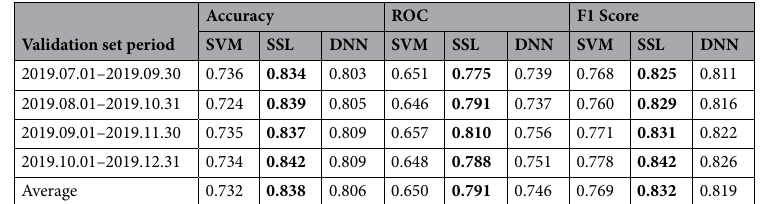
Validation set period